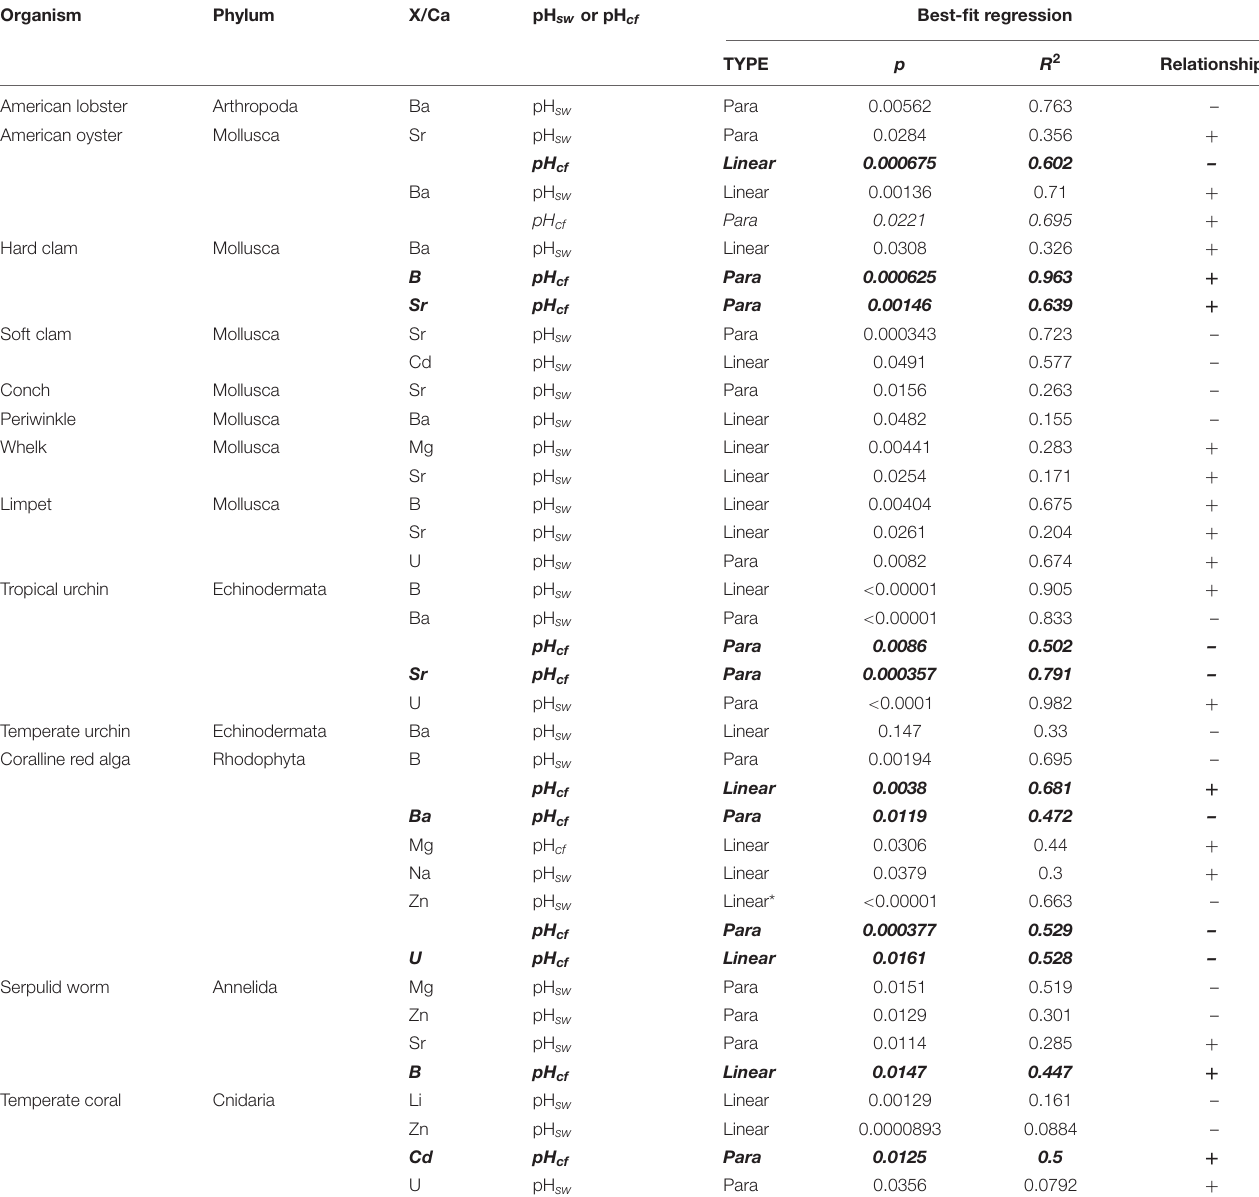
TABLE 5 | Summary of AIC test results for significant relationships ( p < 0.05) between element/Ca ratios and seawater pH and δ 11 B-derived calcifying fluid pH (indicated with bold italic text) across all organisms.